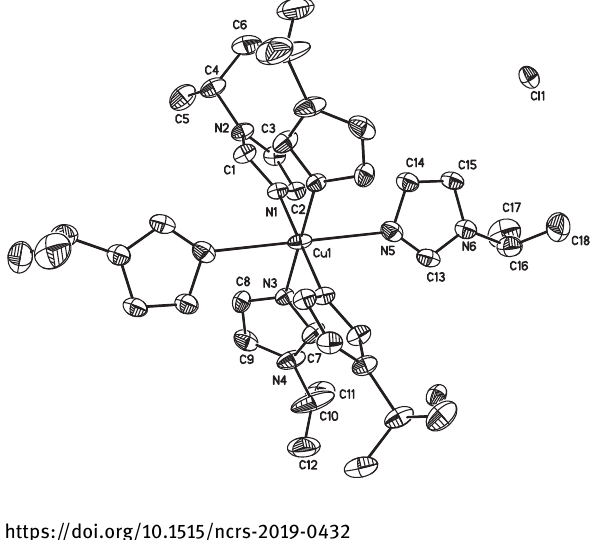
Table 1: Data collection and handling.